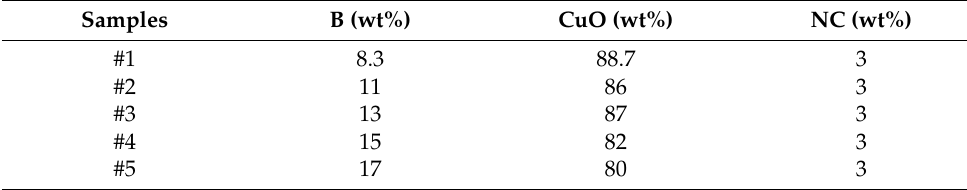
Table 1. Compositions of B/NC/CuO